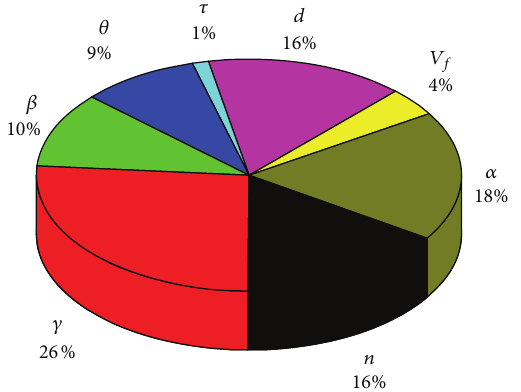
Figure 14: The relative contribution of various parameters on the sensitivity of 𝑁 . 𝑛 : the ratio of pipe force and material strength, 𝛾 : the ratio of main pipe diameter and thickness, 𝛽 : the ratio of main pipe diameter and branch pipe diameter, 𝜃 : branch pipe axis and main pipe axis angle ( ∘ ) 𝜏 : the ratio of main pipe wall thickness and branch pipe wall thickness, 𝛼 : fiber braiding angle ( ∘ ), 𝑉 𝑓 : fiber volume content (%), and 𝑑 : the main pipe diameter